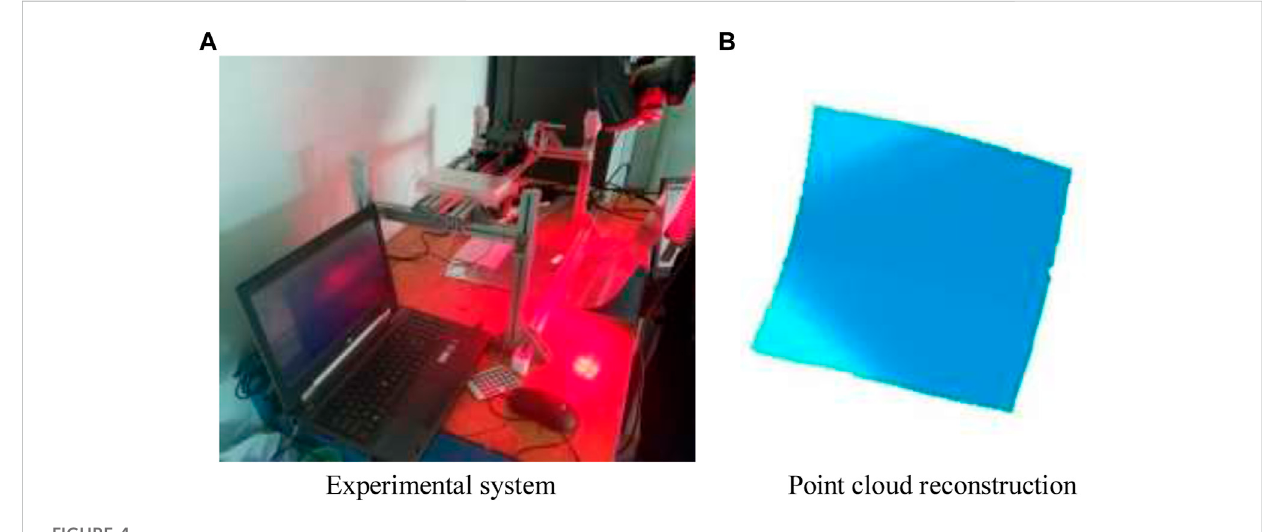
FIGURE 4 Comparative experimental system.